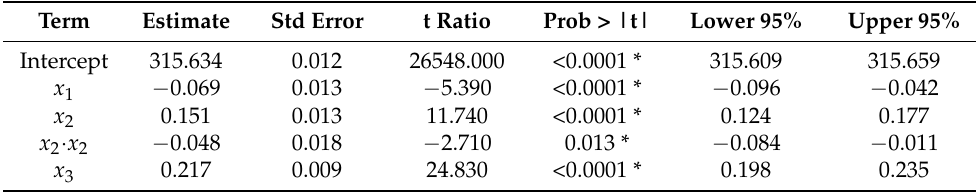
Table 12. Estimation of model